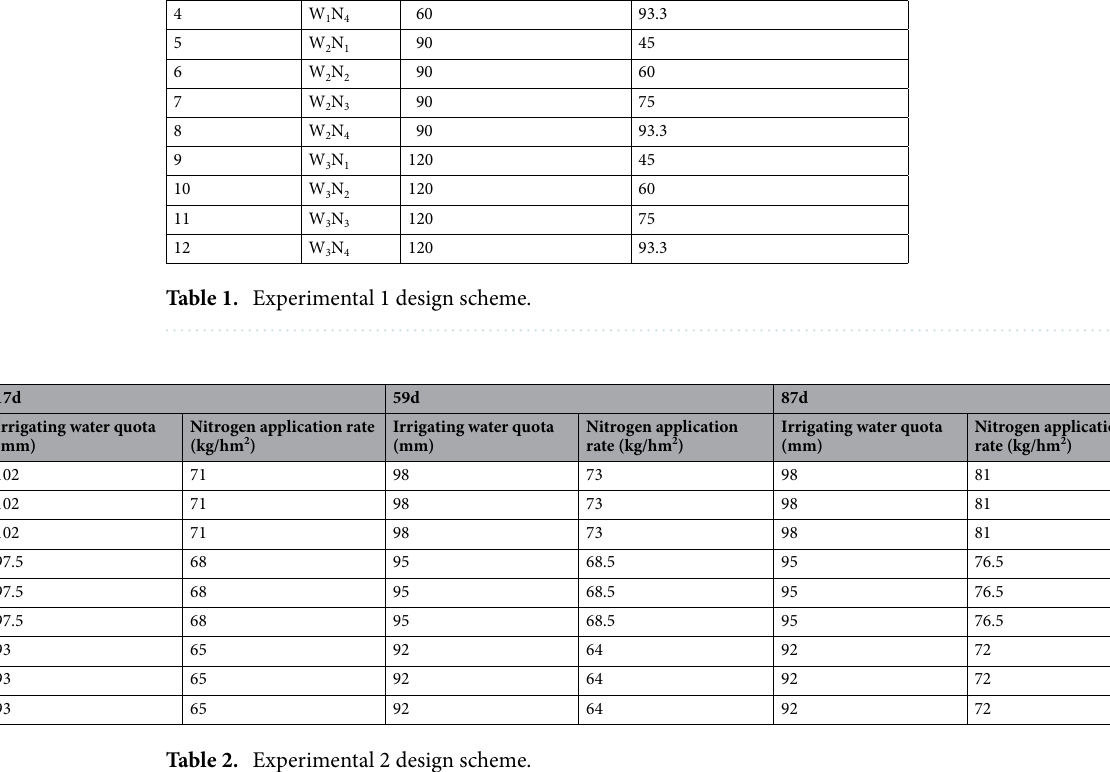
Table 2. The experimental design were repeated for three times. The plot area of each treatment measuring 8 × 9 = 72 m 2 . The surrounding area was separated using 1.2 m buried polyethylene plastic film, and 30 cm was left at the top to prevent fertilizer and water from flowing into each other. The field management process was consistent with that used by the local farmers. The film width of maize was 1.1 m, with each film covering two rows. The plant spacing was approximately 45 cm, and the row spacing was 35 cm. In addition, the planting density of the maize was 60,000 plants/hm 2 . During the entire growth period of the maize crops, soil samples were collected from the 0 to 20 cm, 20 to 40 cm, 40 to 60 cm, 60 to 80 cm, and 80 to 100 cm soil layers using a soil drill and a three-point method was adopted. The soil samples were stored at 4 °C for the determination of total nitrogen, organic matter, total salt content, and pH values. The total nitrogen, organic matter, total salt content, and pH were determined using a Soil parameters measured include organic matter (SOM), total nitrogen (TN), Salt and pH. The data set includes pre-irrigation and post-irrigation reports from 2018 to 2020. Statistical parameters regarding the soil data are shown in Table 3. The dataset obtained in Experiment 1 in 2018 to 2019 was 2490 rows in size, the 80/20 principle was used to data into training, and testing sets were required for ML modeling; 80% of data were employed for model training, while the remaining 20% were used for testing. Specifically, the data corresponding to the treatments with the nitrogen application rate (N rate) of 75 kg/hm 2 (N3) in all the treatments (W1N3, W2N3, W3N3) were used as the test set, and the data of the other treatments were used as the training set. The training set was used to initiate ML parameter training. Subsequently, The test set was employed to assess the model. The dataset size in 2020 was 1080 rows, which was used to verify ML modeling. Figure 3 shows the changes of soil indexes over time for each treatment in the field test (take the 0–40 cm soil in the main distribution area of maize roots as an example). There are differences under the influence of different irrigation amounts. When irrigation is 90 mm, soil SOM is 13.25% and 7.00% higher than 60 mm and 120 mm, and soil TN is 4.59% and 6.50% higher than 60 mm and 120 mm, respectively. The soil Salt was 23.30% lower than 60 mm, and the pH was 4.16% and 4.36% lower than that of 60 mm and 120 mm, respectively. It can be seen